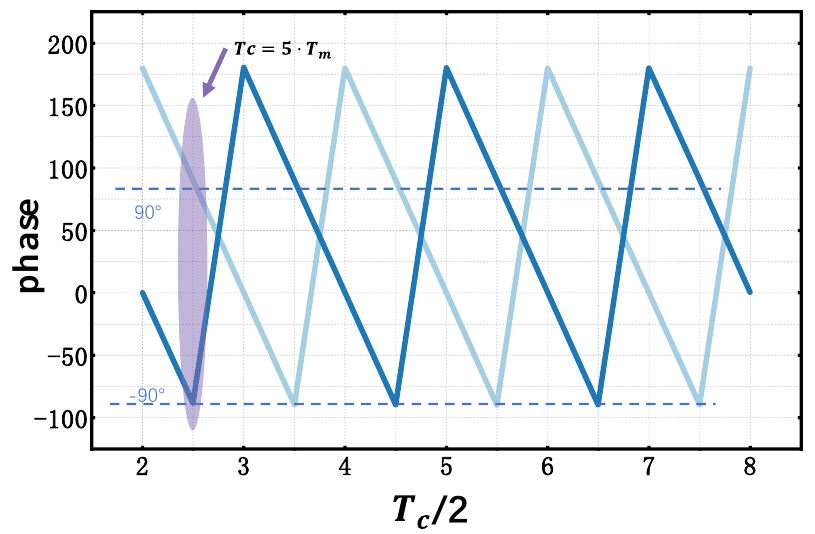
Figure 7. The phase change is caused by the periods of the control signals.